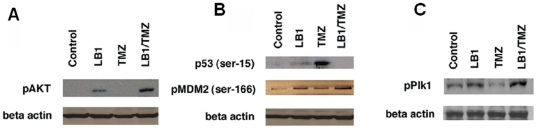
Western blot on PHEO tumors.Changes in the state of phosphorylation and abundance of small pAKT, p53, pMDM2, and pPlk-1 24 hours after treatment of mice bearing hepatic tumors with vehicle, LB1 alone at 1.5 mg/kg by gavage, TMZ alone by gavage at 80 mg/kg, of both drugs at the same doses. (A) Western blots show that LB1 exposure increases pAKT in control-untreated tumors and treated tumors. TMZ does not change the expression of pAKT and combination of LB1 plus TMZ highly increases pAKT expression. (B) Western blots demonstrate marked increased expression of p53 after TMZ but complete inhibition of this induction by exposure to LB1 accompanied by an increase in the expression of pMDM2 in tumor cells exposed to LB1 alone or in combination with TMZ (C) Expression of pPlk1 shows a marked increase in tumors after exposure to the combination of drugs.